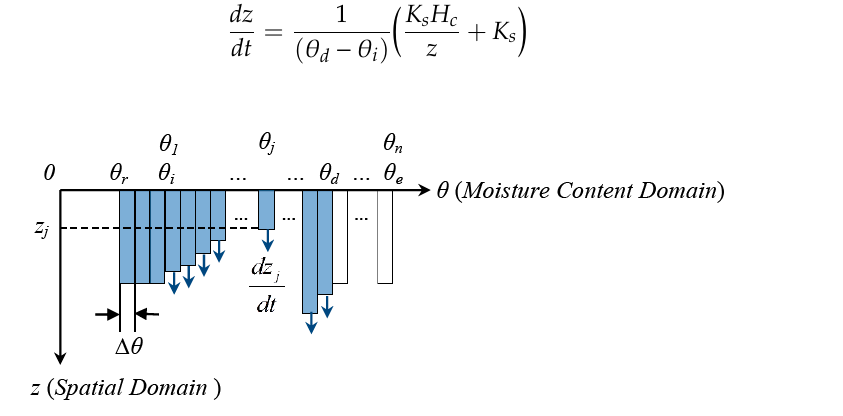
Figure 2. The infiltration in the Talbot–Ogden model.